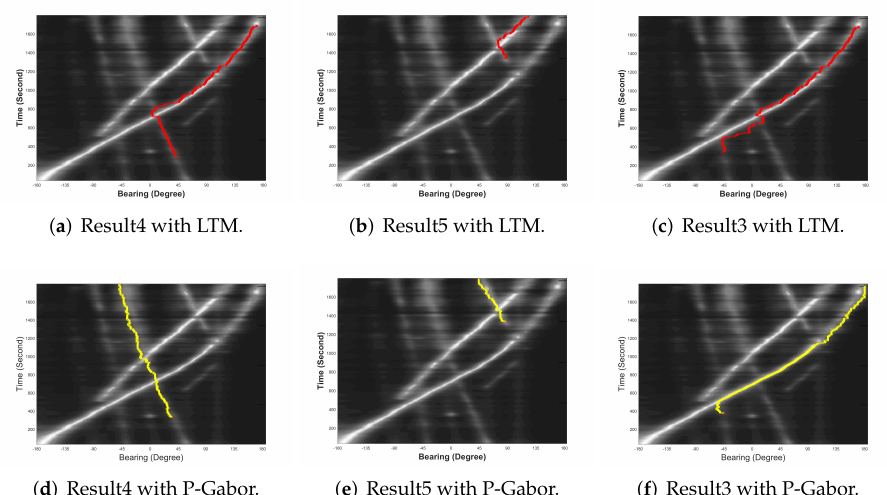
Figure 13. Experiment results with strong jamming targets.